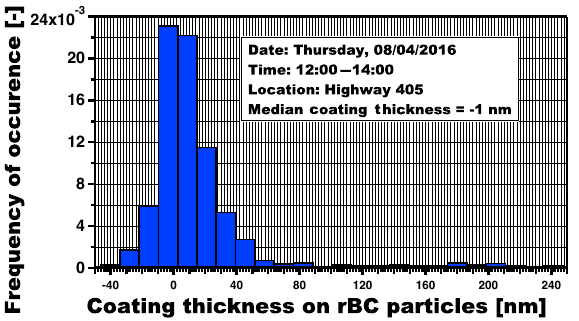
Figure 4. Coating thickness histogram for rBC-containing particles as estimated using the leading-edge-only (LEO) method. Measure- ments were made at downwind distances ranging from 30 to 114m (100–375 ft.) of Interstate 405 in Los Angeles on 4 August